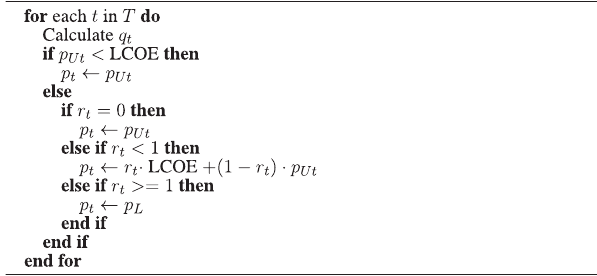
Algorithm 1: Algorithm for LEM pricing scheme with dynamic